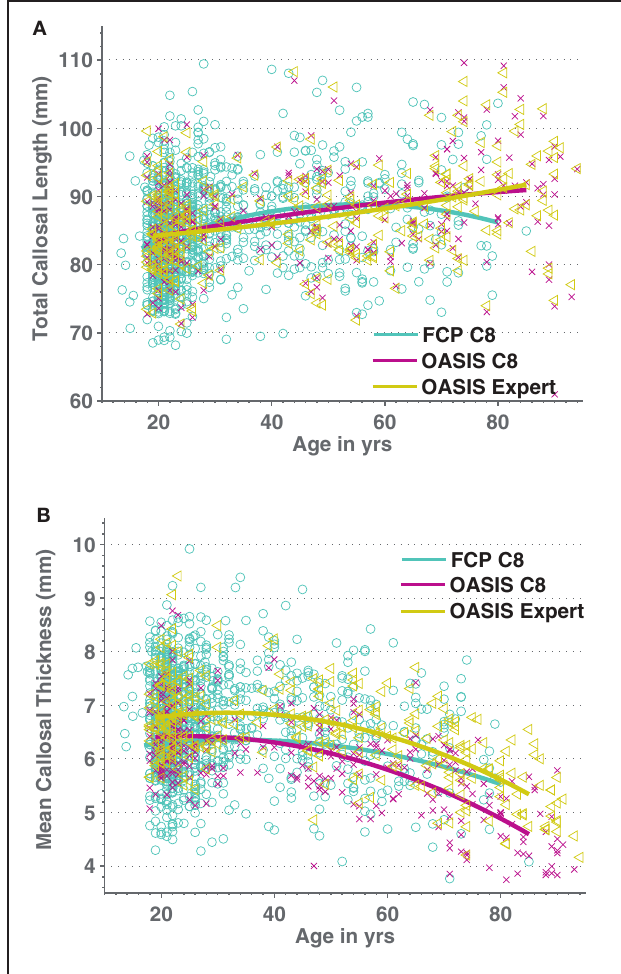
FIGURE 7 | Scatterplots of Age vs. medial callosal length (A) and Age vs. mean callosal thickness (B) for 1227 FCP database images processed by C8 (cyan/circles) as well as for both automated (purple/crosses) and expert-corrected (gold/triangles) segmentations of 316 OASIS control subjects. Estimated quadratic age regression lines are